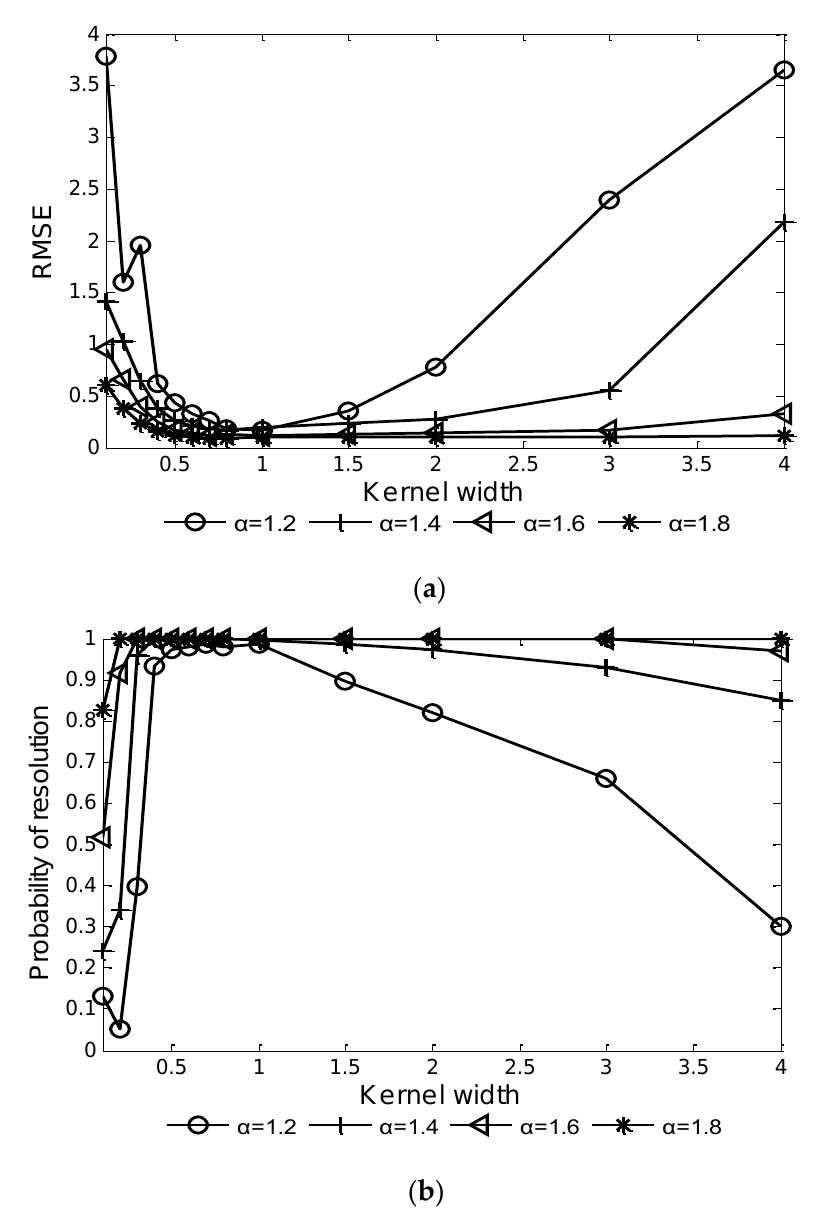
Figure 3. Performance of FLOCRAF-ESPRIT algorithm vs kernel width ( GSNR = 5 dB ): ( a ) RMSE; ( b ) Probability of resolution.